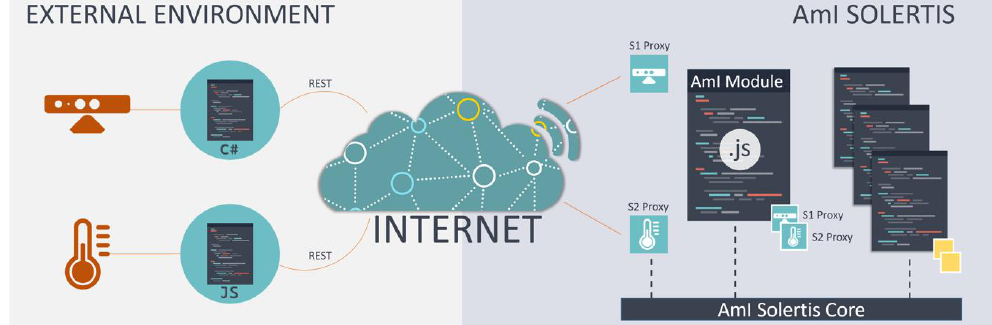
Figure 4. The AmI-Solertis Hybrid Communication protocol.